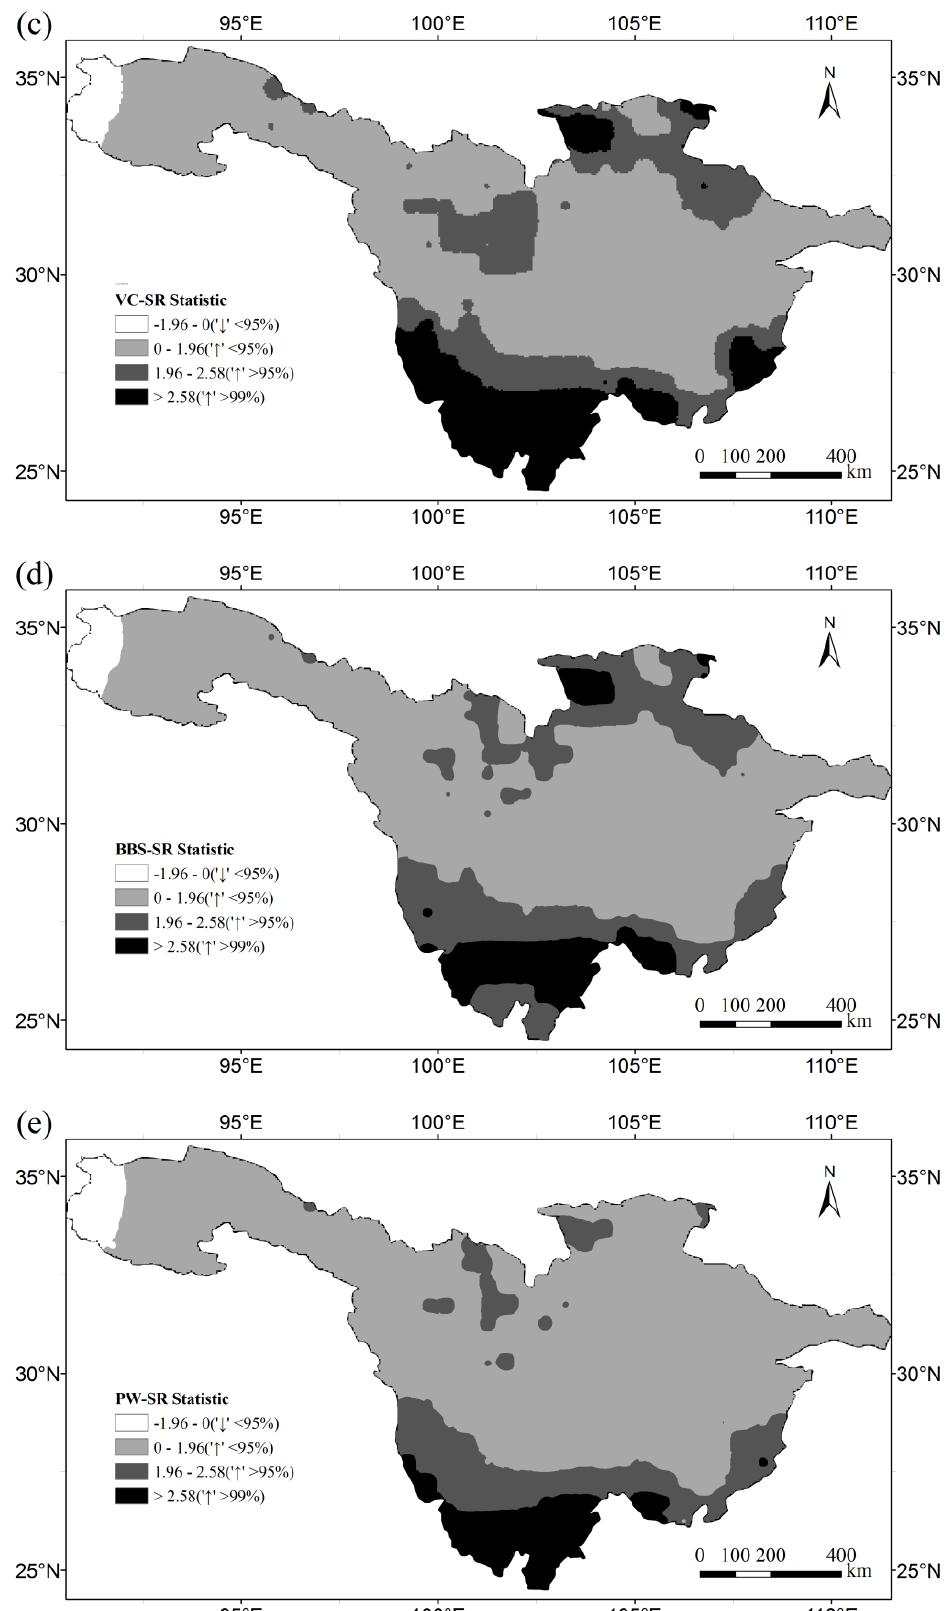
Figure 11. Spatial distribution of trend detection results of PET data: ( a ) the original SR test; ( b ) the TFPW-SR test; ( c ) the VC-SR ESS+Est. r test; ( d ) the BBS-SR test; ( e ) the PW-SR test.